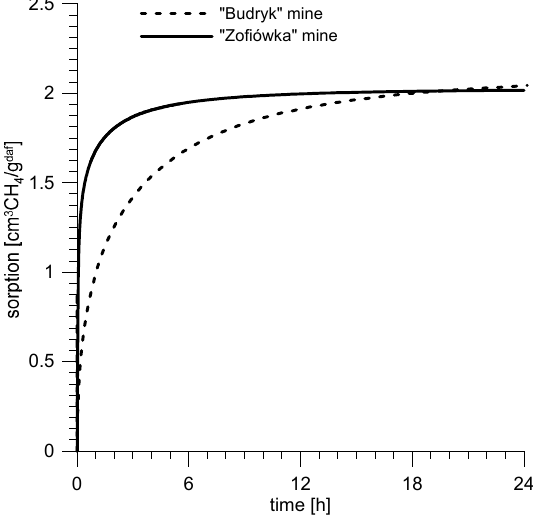
( b ) Figure 4. ( a ) Direct results of the sorption measurements—coal from the Zofiówka coal mine. ( b ) A sorption isotherm of the coal from the Zofiówka coal mine. ( a )